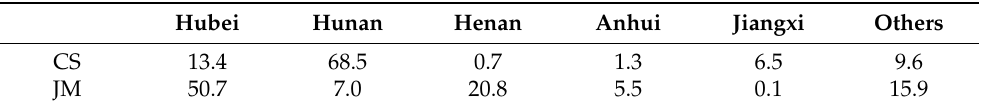
Table 3. Contribution rates (%) of main contributing provinces to PM 2.5 concentrations in CS and JM for winters from 2016–2020. Hubei Hunan Henan Anhui Jiangxi